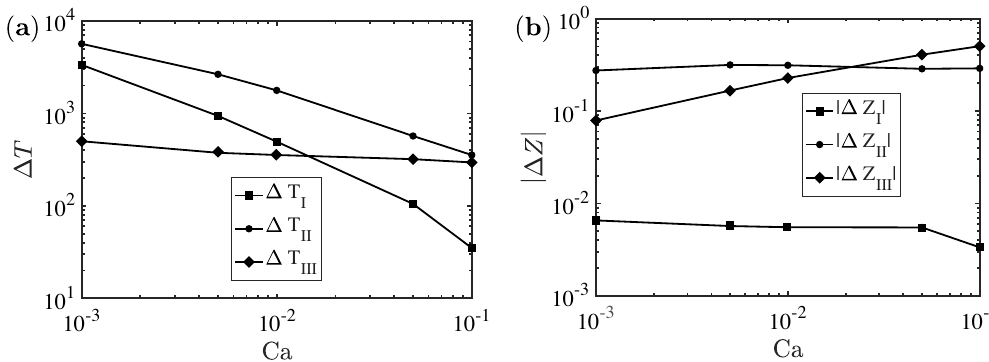
Figure 9. ( a ) Phase duration and ( b ) corresponding displacement attained versus capillary